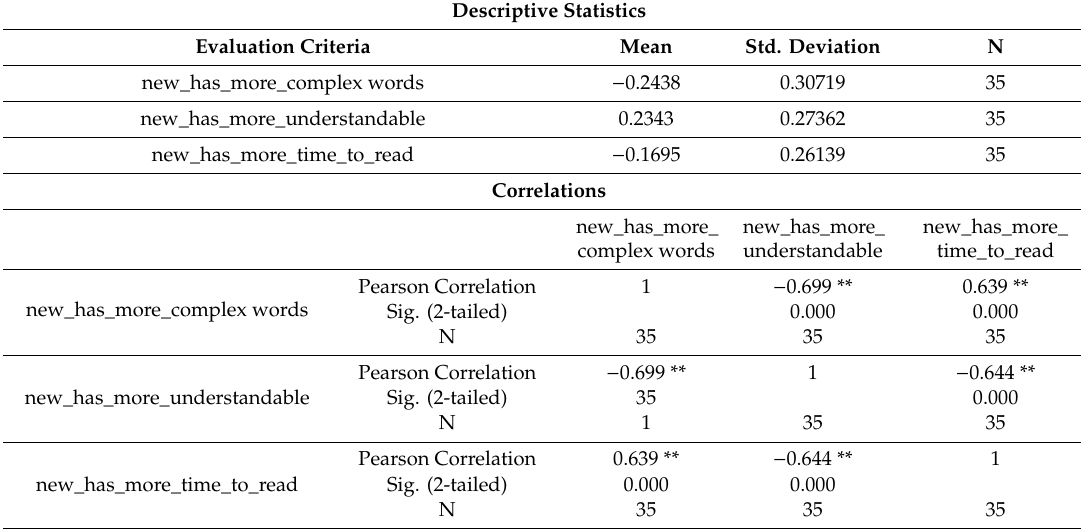
Table 8. Result of the correlation between three main